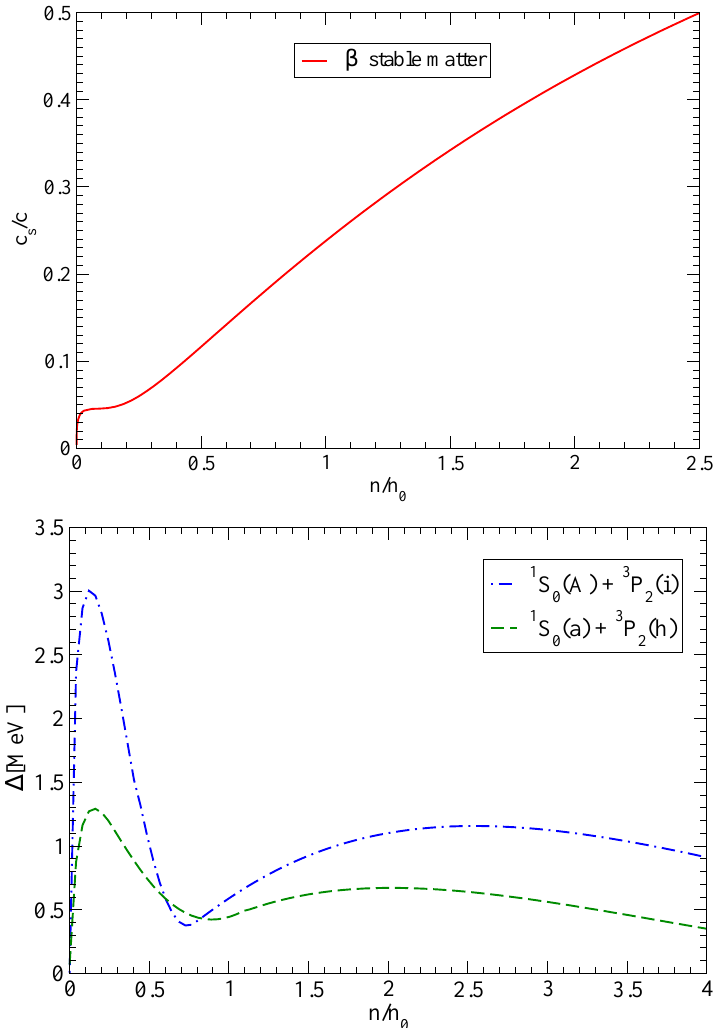
Figure 1. Upper panel: c s / c for β -stable nuclear matter as a function of particle density. Lower panel: The combination of 1 S 0 and angle-averaged 3 P 2 neutron gaps as a function of density for two different gap cases. Figures adapted from [6,8,18]. Adapted from [18] with the permission of AIP